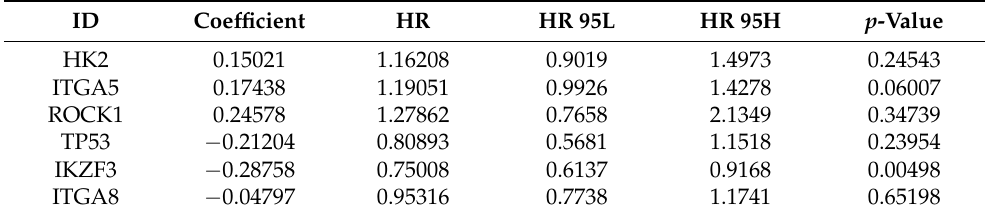
Table 1. Multivariate Cox regression analysis for the prognostic signature based on the six ANRGs.